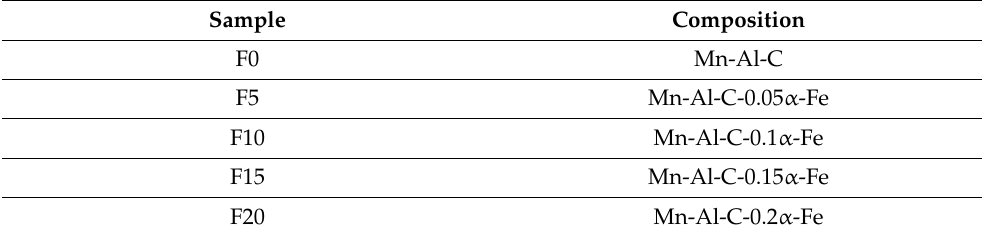
Table 1. Alloy samples with different α -Fe content.